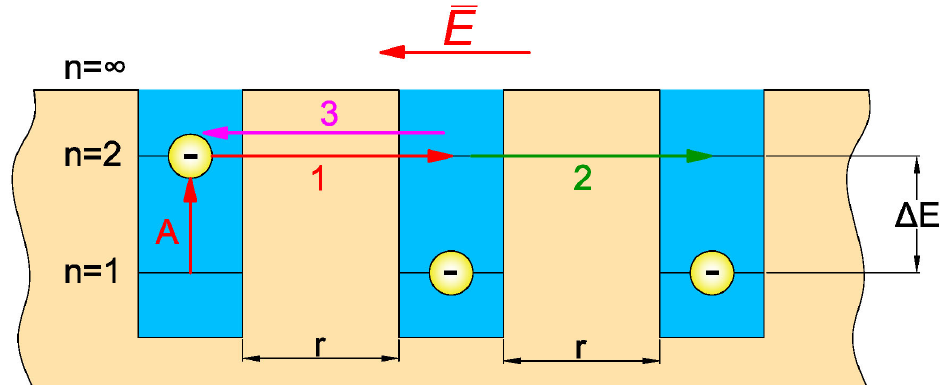
Figure 2. Potential wells: A—excitation of the electron from the highest occupied state to the lowest unoccupied state, 1—tunneling of the electron from the left well to the middle well, 2—tunneling from the middle well to the right well, 3—return tunneling from the middle well to the left well, ∆ E —distance between occupied and unoccupied states or activation energy of tunnelling, r—distance between wells of